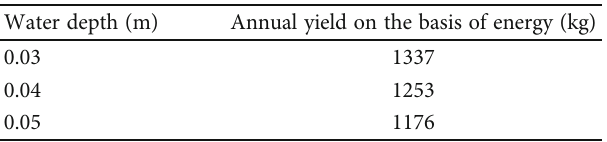
Figure 22: Productivity comparison of solar still containing freshwater, saline water, and solar still coupled with a fl at plate collector containing freshwater [59]. Table 2: Solar still annual yields on the basis of energy for a di ff erent water depth